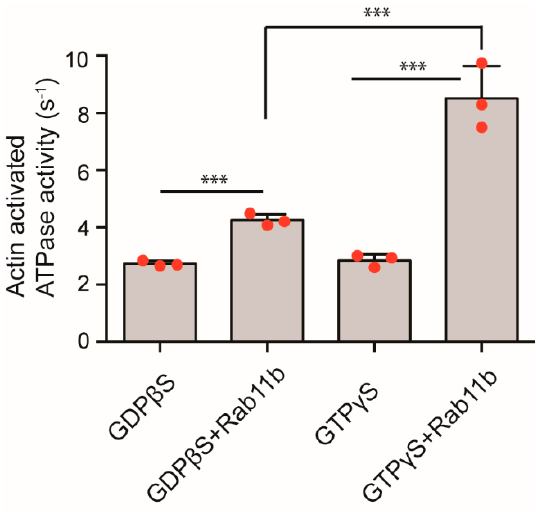
Figure 12. Effect of Rab11b on actin activated ATPase activity of Myo5b. Rab11b and GDP β S or GTP γ S were pre-incubated at 37 °C for 30 min, and the ATPase activity of Myo5b with 20 μ M F-actin in 1 mM EGTA at 37 °C was measured in the presence or absence of 15 μ M Rab11b as described in “Materials and Methods” ( n = 3, mean ± SD). *** p < 0.001. The red spots in bar graph displays the distribution of data points.